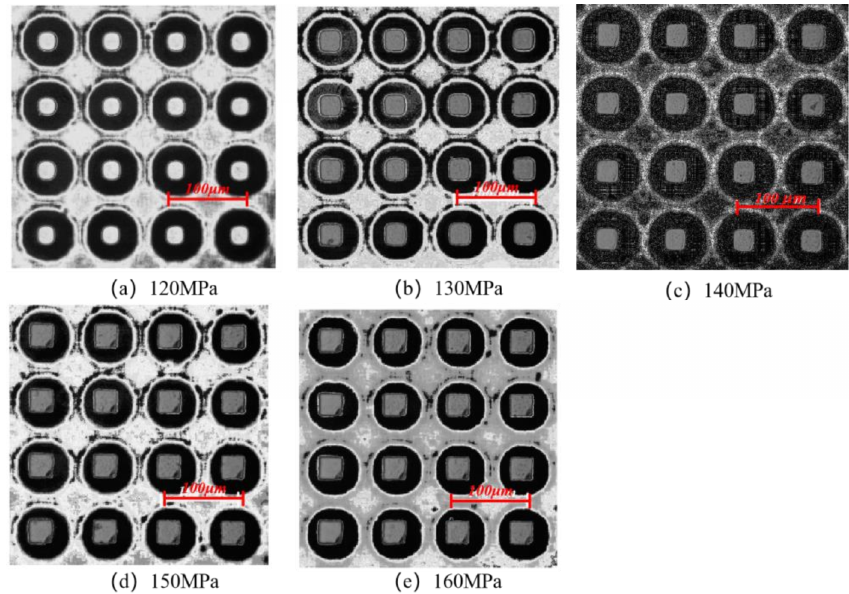
Figure 14. Microstructure replication at morphologies different packing pressures.